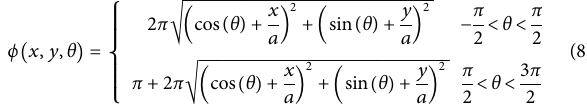
FIGURE 6 | Interface of plasmonic coupling with gold nanoparticle (xz plane) (Complete with permission from Wang et al. (2009). Copyright 2009 American Chemical